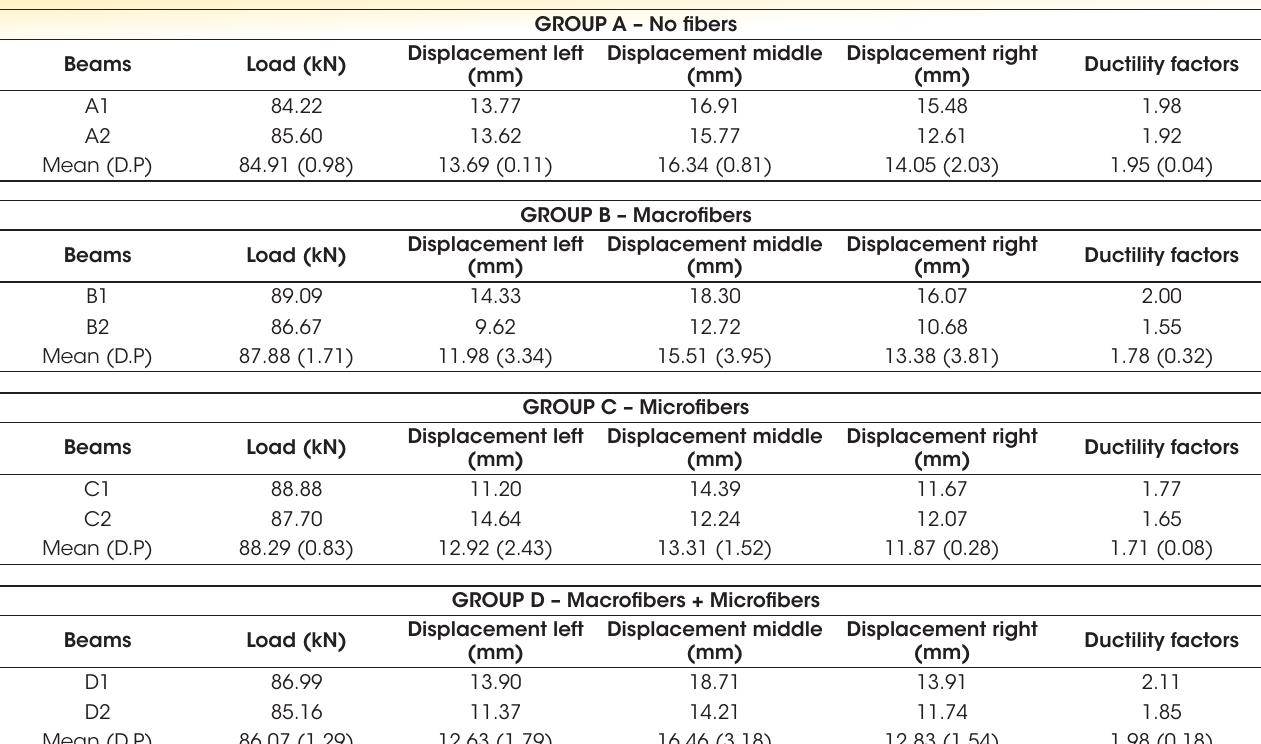
Results of loading and displacement of the beams at rupture (12 × 20 × 160 cm) GROUP A – No fibers